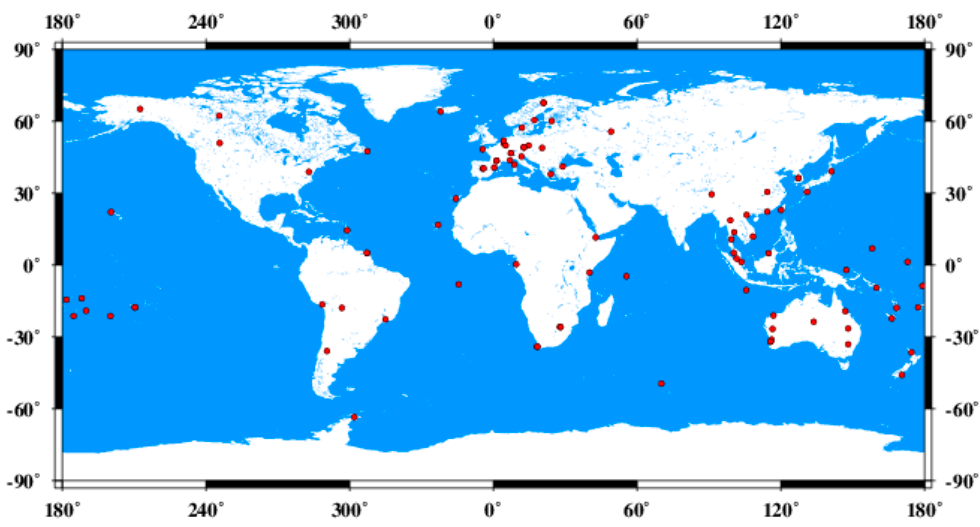
Figure 1. Distribution of MGEX stations used for BDS orbit determination. This figure is drawn using GMT software [38].